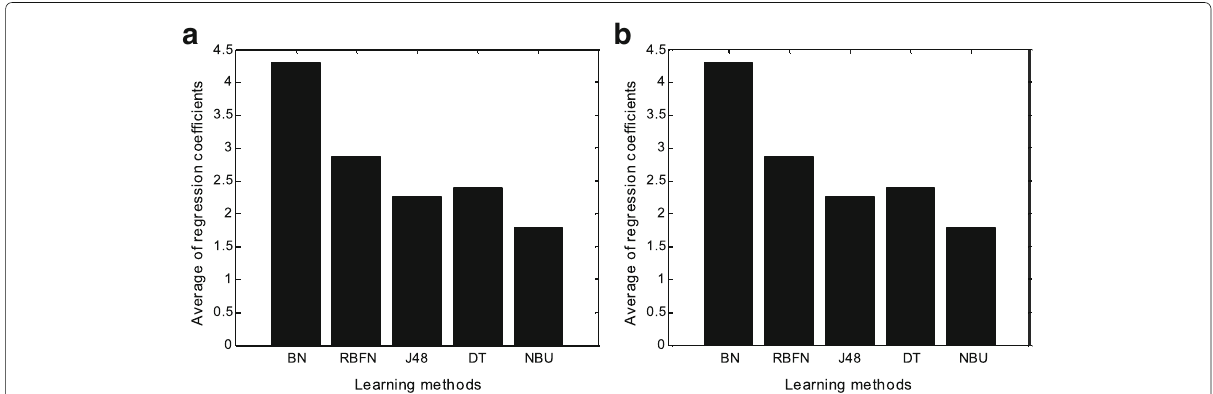
Fig. 6 Averages of the magnitudes of regression coefficients across the learning methods included for a HPCP and b MLD